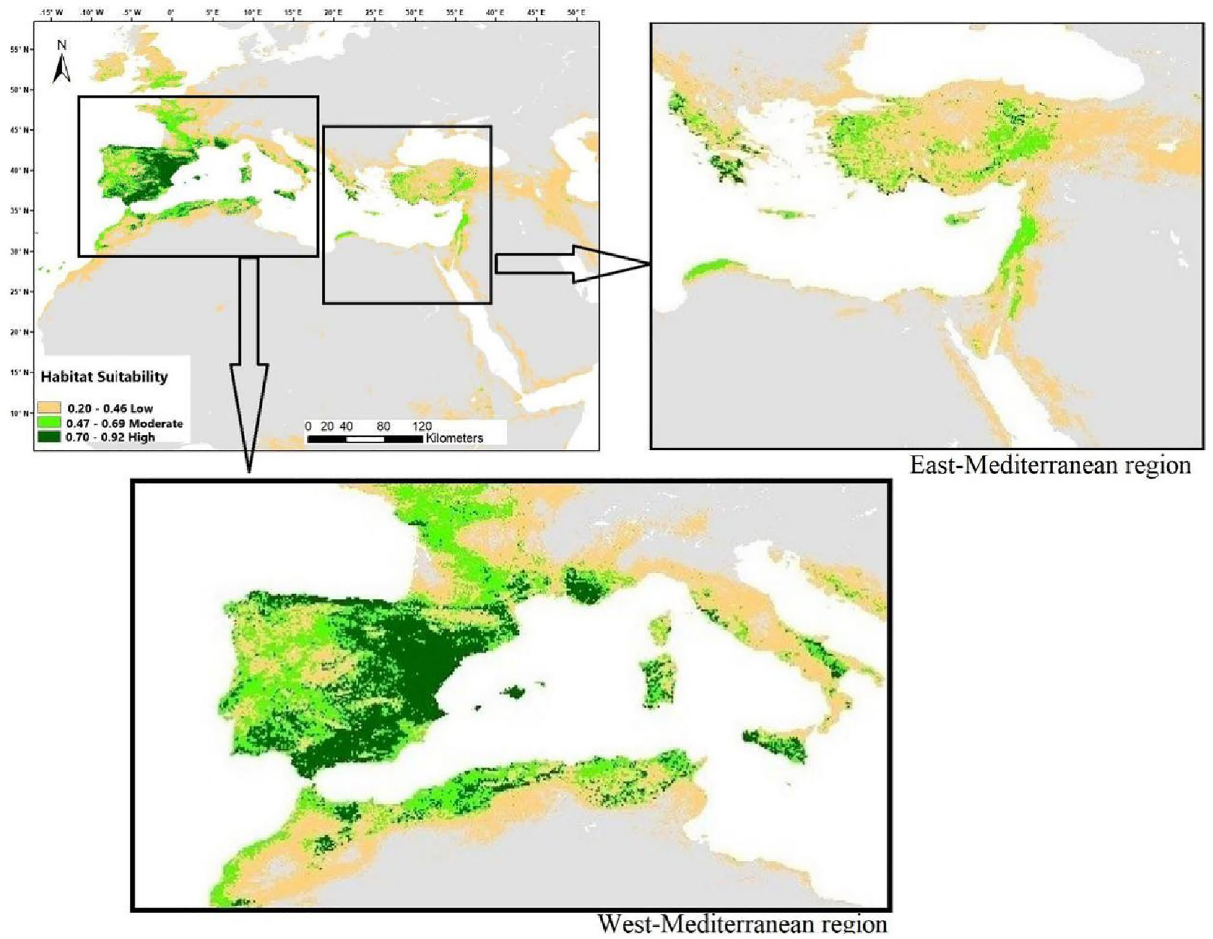
Figure 2. Global potential habitat suitability generated from the ensemble modelling and visualized in ArcGIS 10.5 using the maximum training sensitivity plus specificity threshold